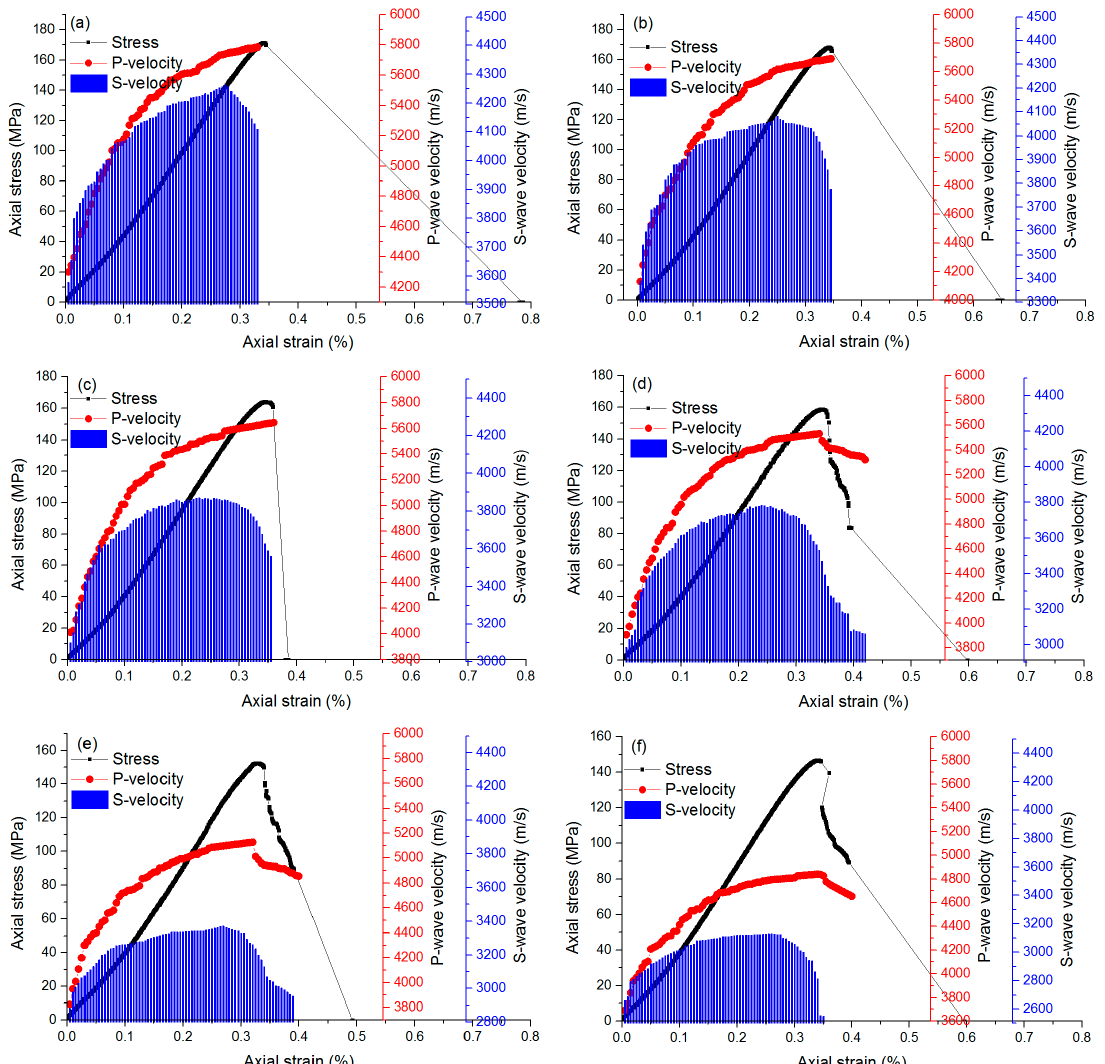
Figure 13. Relationships between the axial stress, P-wave velocity, S-wave velocity and the axial strain. ( a – f ) The granite samples were subjected to 0, 20, 40, 60, 80 and 100 F–T cycles.